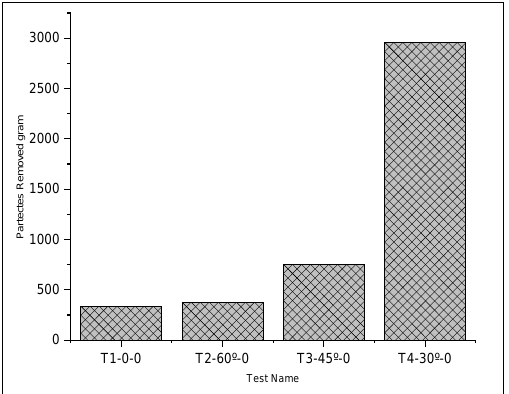
Figure 9. Effect of fan blade angle on the weight of removed sediments.